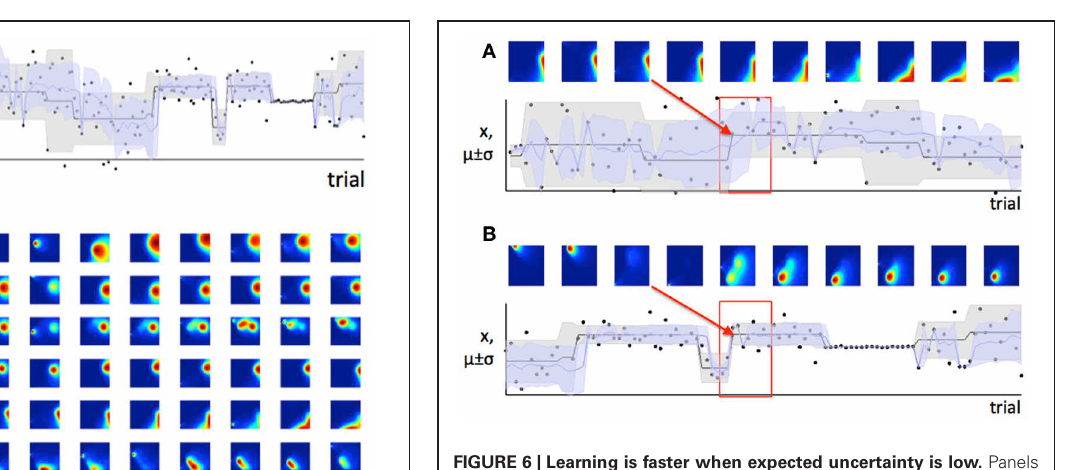
FIGURE 6 | Learning is faster when expected uncertainty is low. Panels (A) and (B) show two sets of trials which include changes of similar magnitude in the mean of the generative distribution (distribution from which data were in fact drawn). In panel (A) , the estimate of σ i is high (high expected uncertainty) but in panel (B) , the estimate of σ i is lower—this is indicated by the distribution of probability density from left to right in the colored parameter-space maps, and also the width of the shaded area μ ± σ on the lower plot. The red boxes indicate the set of trials shown in the parameter space maps; the red arrow shows which parameter space map corresponds to the first trial after the change point. Note that the distribution of probability in parameter space changes more slowly when expected uncertainty is high (panel A ), indicating that learning is slower in this case. FIGURE 7 | Change in the environment increases estimation uncertainty. Here we see a set of trials during which a change point occurs (change point indicated by red arrow). Before the change point, the model has low estimation uncertainty (probability density is very concentrated in a small part of parameter space, as seen from the first three parameter space maps). When the change point is detected, estimation uncertainty increases as the model initially has only one data point on which to base its estimate of the new parameters of the distribution. Over the next few trials, estimation uncertainty decreases (probability density becomes concentrated in a smaller part of parameter space